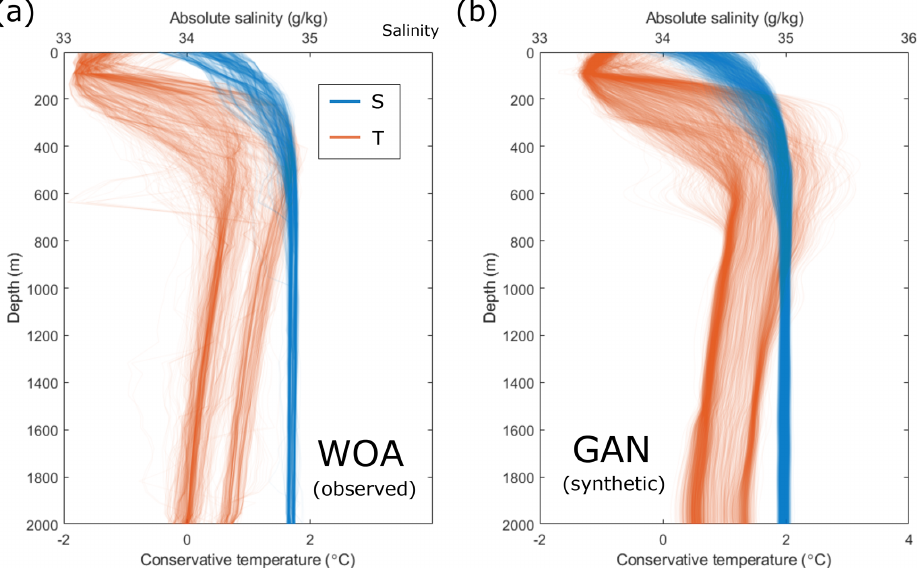
Figure D2. Temperature and salinity profiles (a) extracted from the WOA dataset (Boyer et al., 2018) from the closest 2000m depth cell around Antarctica ( N = 1440) and (b) generated from the GAN ( N = 5000), trained on the WOA data shown in (a) . WOA data are converted to the TEOS10 standard (Intergovernmental Oceanographic Commission et al., 2015), prior to being used to train the